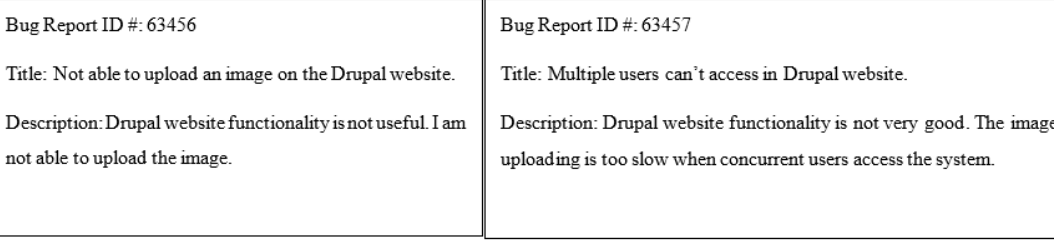
Figure 2. Example of bug reports .